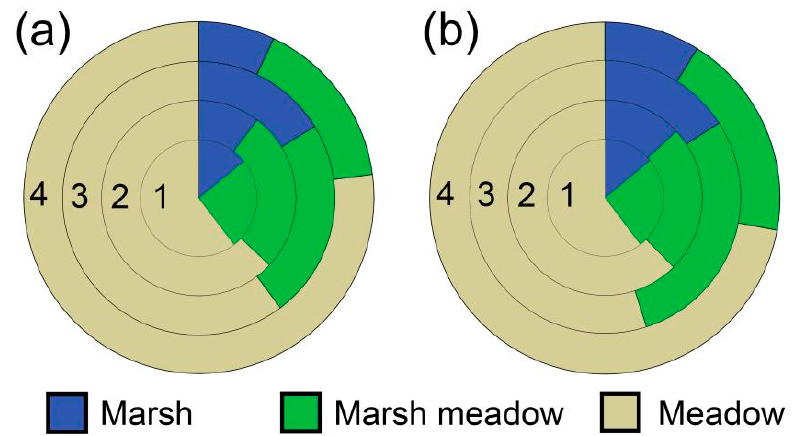
Figure 5. Area proportions of three habitats (marshes, marsh meadows, and meadows) within home ranges of black-necked cranes during four breeding stages: 1, preincubation; 2, incubation; 3, postfledging; 4, fully fledged; ( a ) 50% FKP; ( b ) 95%